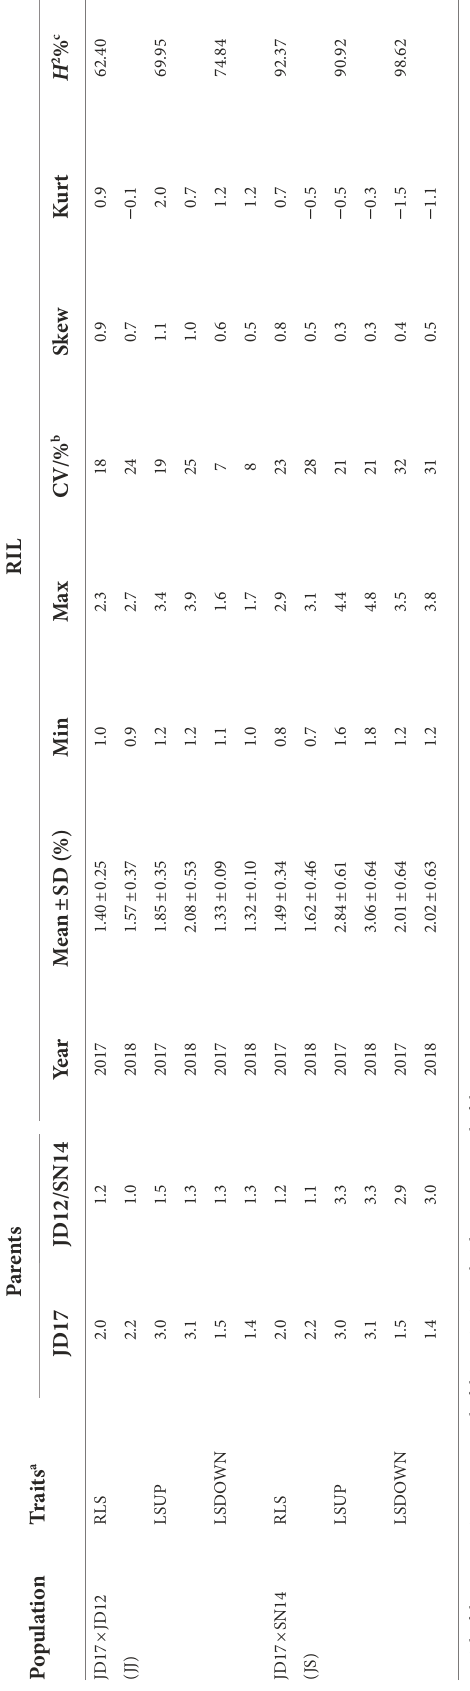
populations fell between the average parent values, and the maximum and minimum values fell beyond the extremes of the parent values. Broad-sense heritability ( H 2 ) for RLS estimated from the JJ and JS populations was 0.62 and 0.92, respectively. For LSUP, the H 2 estimated from the two populations was 0.70 and two populations was 0.75 and 0.99, respectively. These results indicated that the phenotypic variation observed in both the JS population (Table 1). Based on values of Kurtosis and Skewness, all tested traits, except for LSDOWN in JS, fit